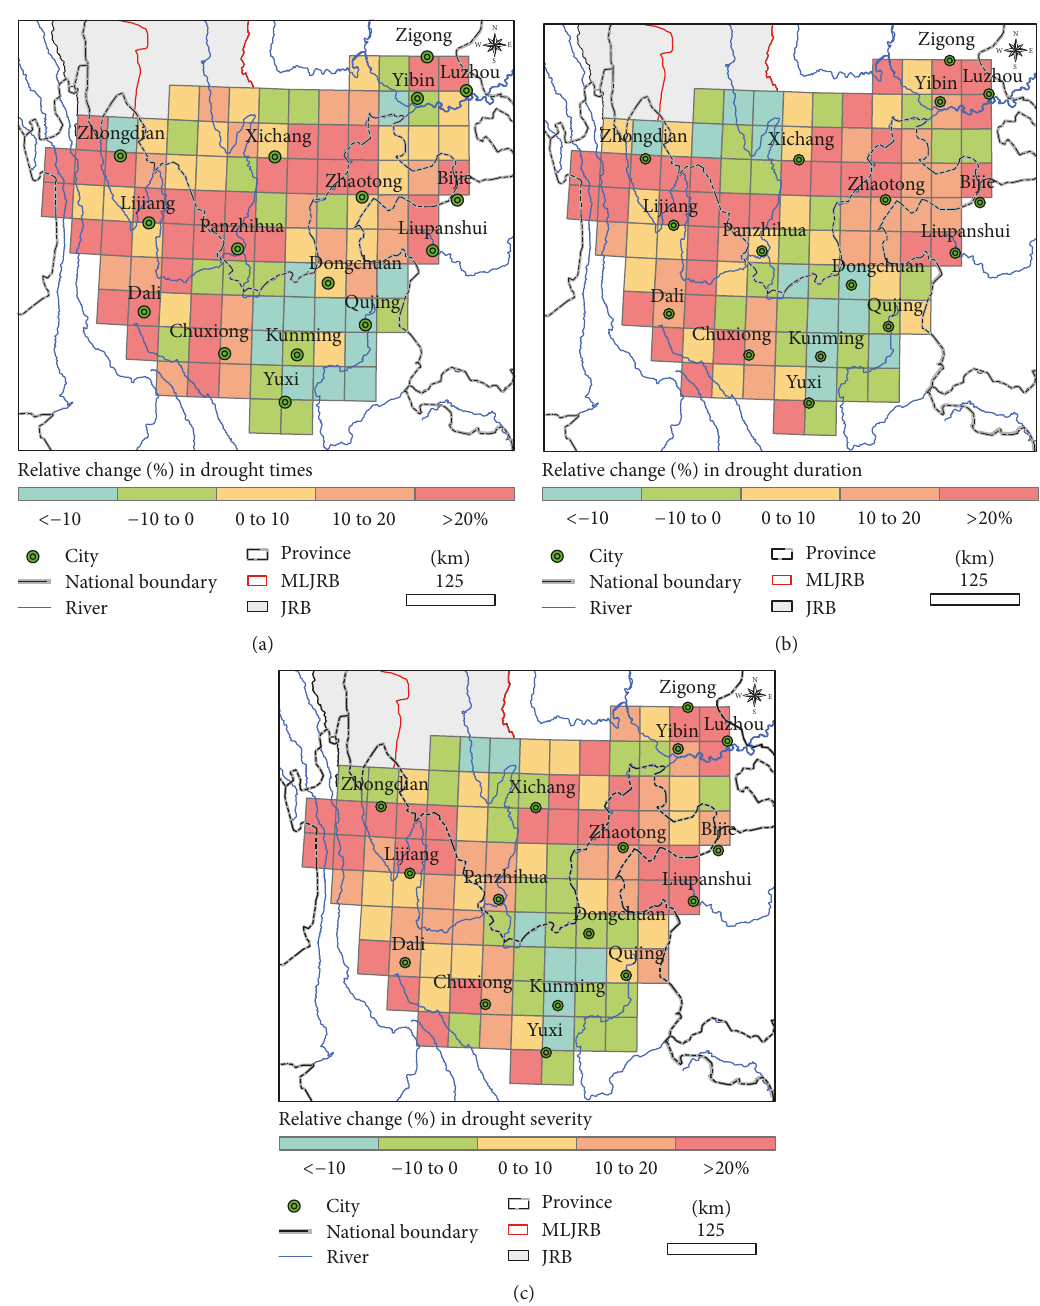
Figure 17: Spatial distribution of the percentage change in drought times (a), duration (b), and severity (c) (%) from the reference period (1961–1990) to